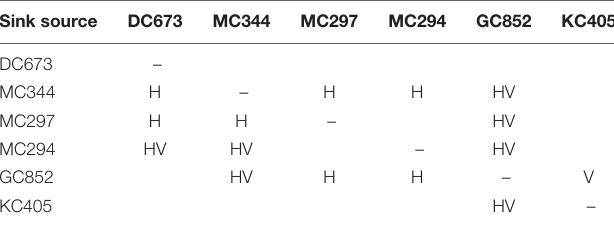
TABLE 1 | Difference in Eulerian and Lagrangian connectivity results, H or V indicates that horizontal or vertical connectivity exists in Eulerian but not in Lagrangian result, while HV indicates both horizontal and vertical connectivity are observed in Eulerian but not in Lagrangian